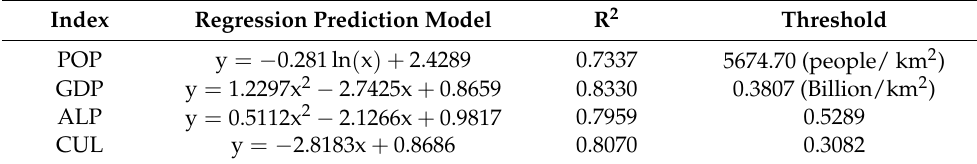
Table 1. Thresholds of urbanization development using regression prediction model.